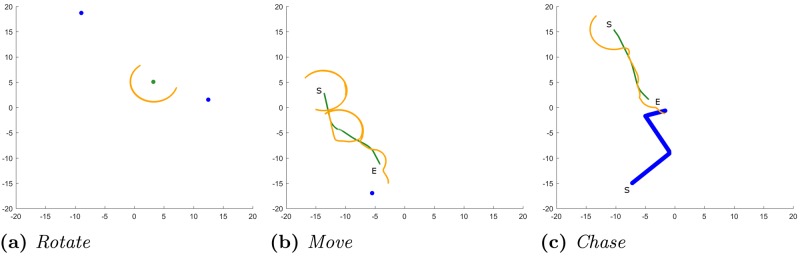
Three exemplary trial results from the simple task phase.The blue circle indicates the target sphere. The green circle/line indicates the position of the participant. The orange line indicates the viewing direction via the location of the catchment area. If a participant or sphere moves, the S indicates the starting location and the E indicates the end location. (a) Rotation from Memory (RFM): The participant rotates back and forth between two spheres. (b) Move with Map (MWM): The participant rotates in the beginning, moves towards the target, and then rotates again. In the end, the participant is slightly inaccurate with respect to the target’s location. (c) Chase (CHA): The participant rotates in the beginning to find the sphere and then intercepts it.